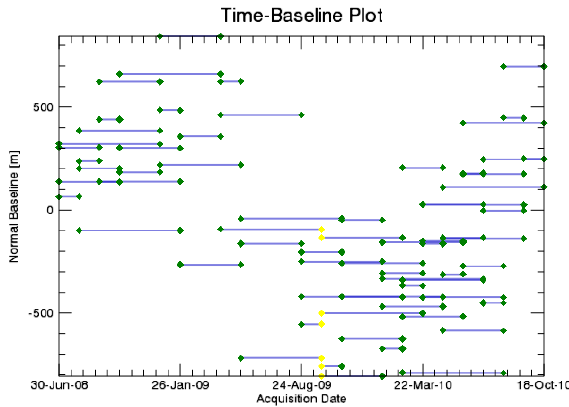
Figure 2. Connection map of the 67 interferograms In connection diagram generating process, to all the SAR images within the range set baseline distance threshold of space and time, like the combination, set up corresponding relation, it is concluded that the connect to the Internet, according to the result of grouping for differential interference processing, can get 67 scene interference figure. SBAS method get time deformation sequence by a pixel count, in order to avoid error, low coherent point in the phase diagram in the differential interference of high coherent point target selection, and then point by point calculation. Using the average coherent value map of all SAR images, the pixels with an average coherence value greater than 0.25 are selected as high coherence points.